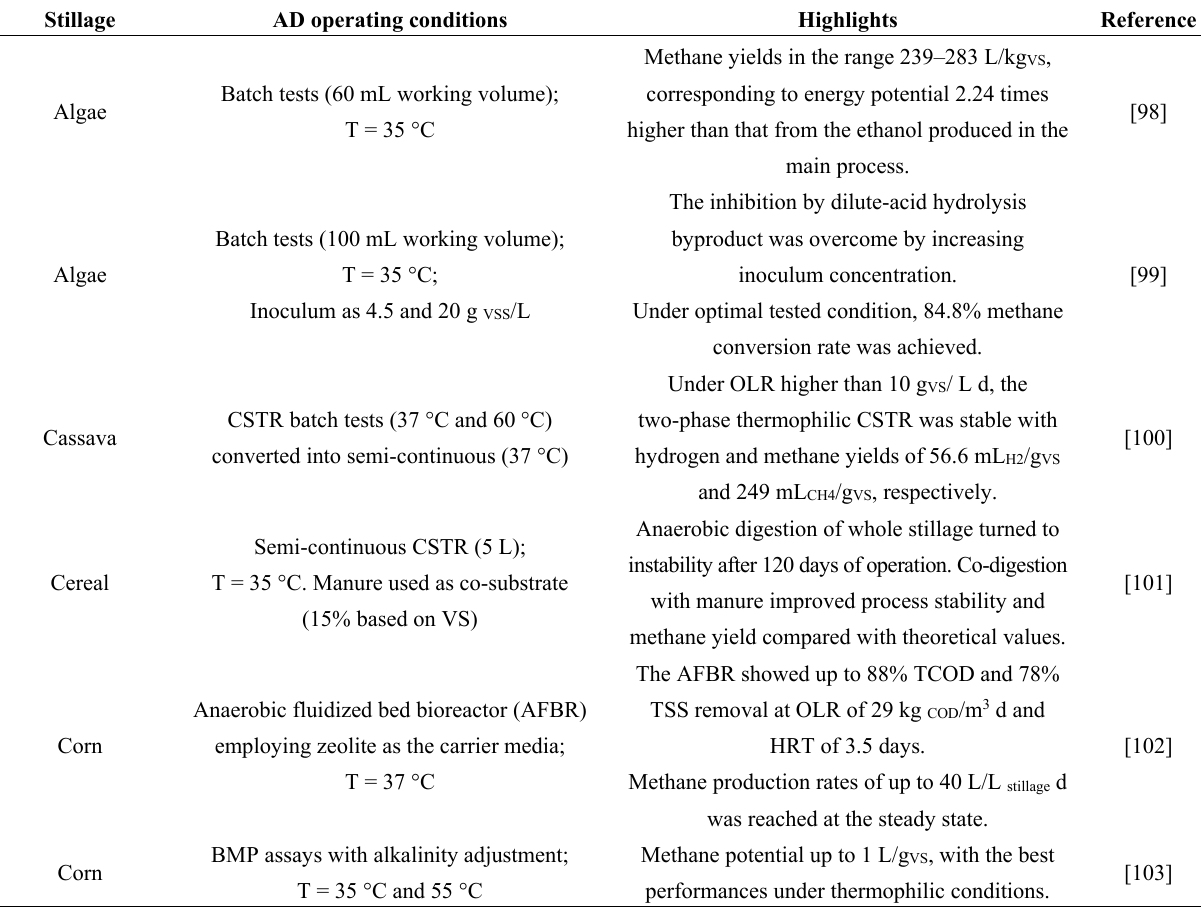
Table 4. Anaerobic processing of different bioethanol